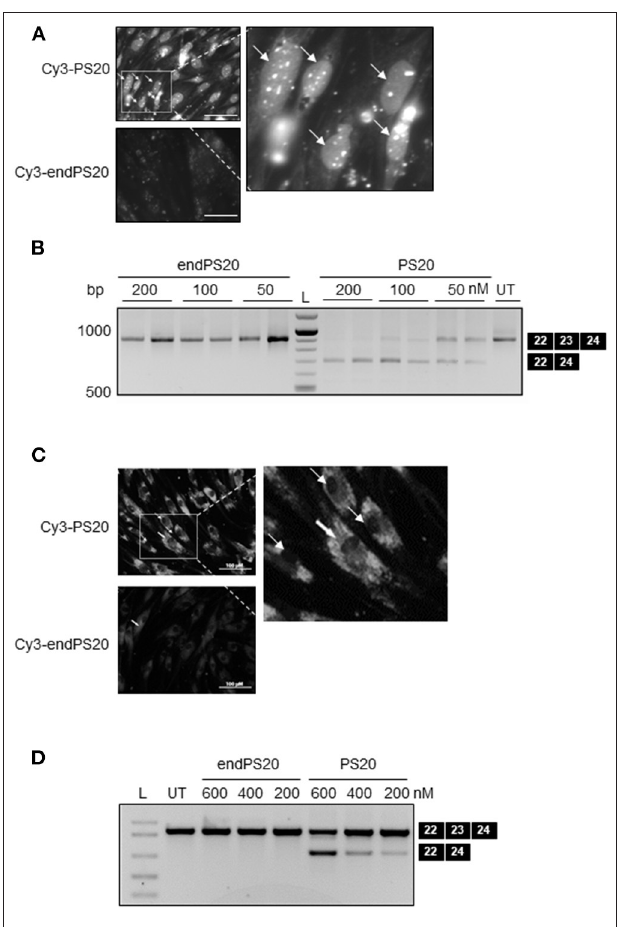
FIGURE 2 | PS-dependent cellular uptake and nuclear accumulation of 2OMe modified splice-switching antisense oligonucleotides (SSOs) in H2k- mdx myoblasts. Cy3-conjugated 2OMePS or 2OMe-endPS SSO with 20 mers were delivered either through gymnotic uptake or by LF2000. (A) Fluorescence microscopy images depicting the cellular uptake of 2OMePS or 2OMe-endPS SSO (200 µ M final concentration) complexed with Lipofectamine 2000 in H2k- mdx myoblasts after 4h post-transfection. Bar = 15 µ m. (B) RT-PCR depicting splice-switching activity of 2OMePS or 2OMe-endPS SSO in